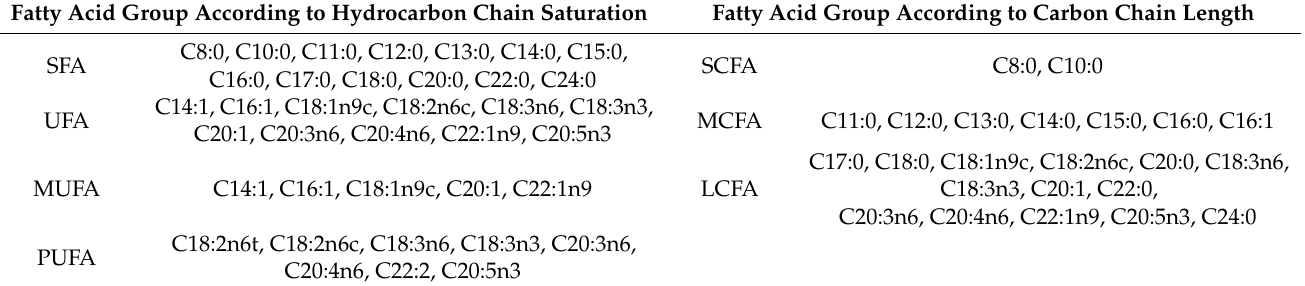
Table 4. Seven classified fatty acid groups, according to hydrocarbon chain saturation and carbon chain length. Fatty Acid Group According to Carbon Chain